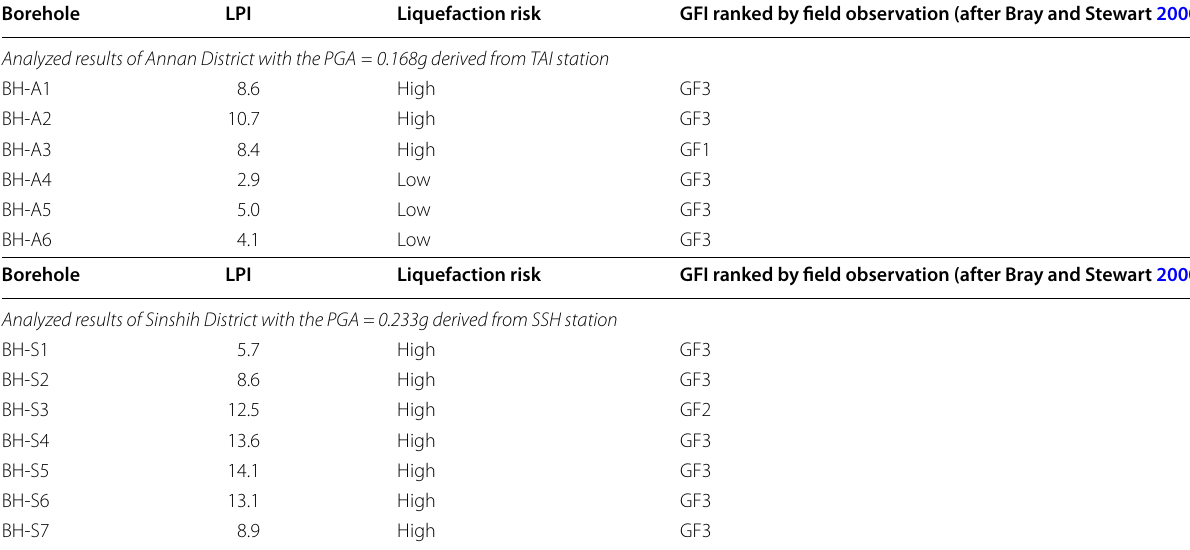
Table 5 LPI evaluation results of the Annan and Sinshih Districts Borehole LPI Liquefaction risk GFI ranked by field observation (after Bray and Stewart 2000) Analyzed results of Annan District with the PGA = 0.168g derived from TAI station